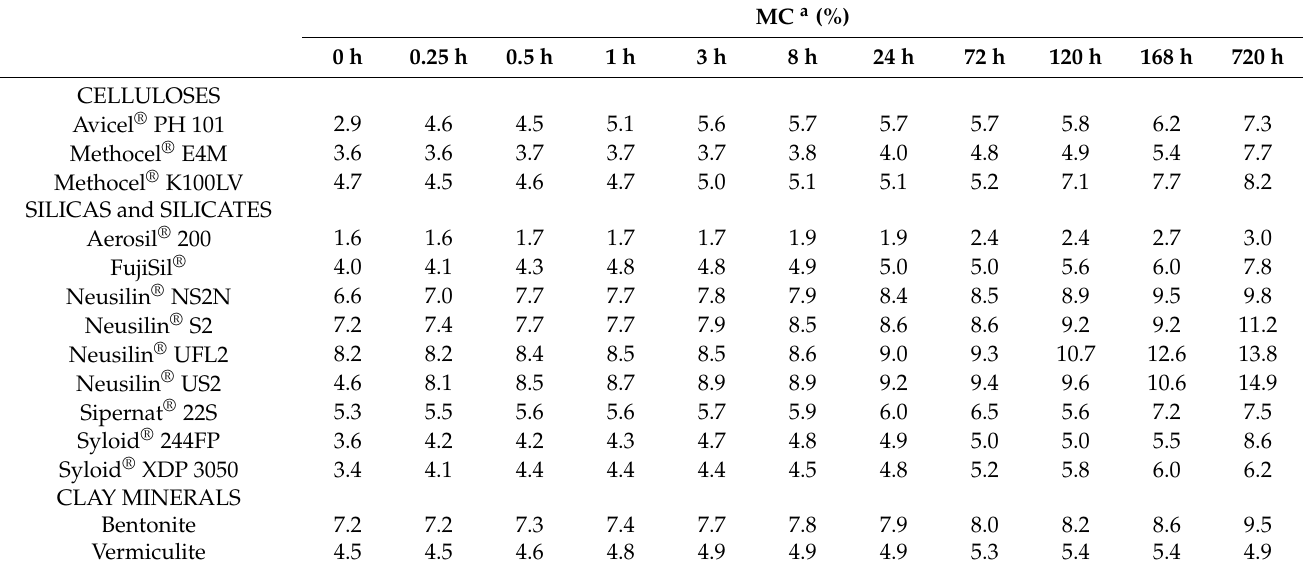
Table 4. Hygroscopicity of powder materials at specific times.